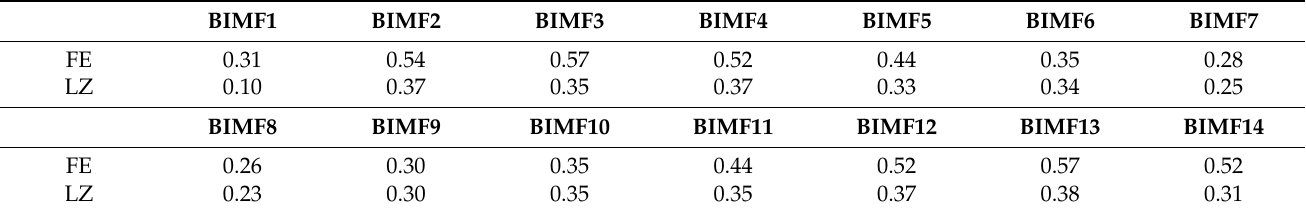
Table 3. Fuzzy entropy and Lempel-Ziv complexity index calculation results for BIMFs.